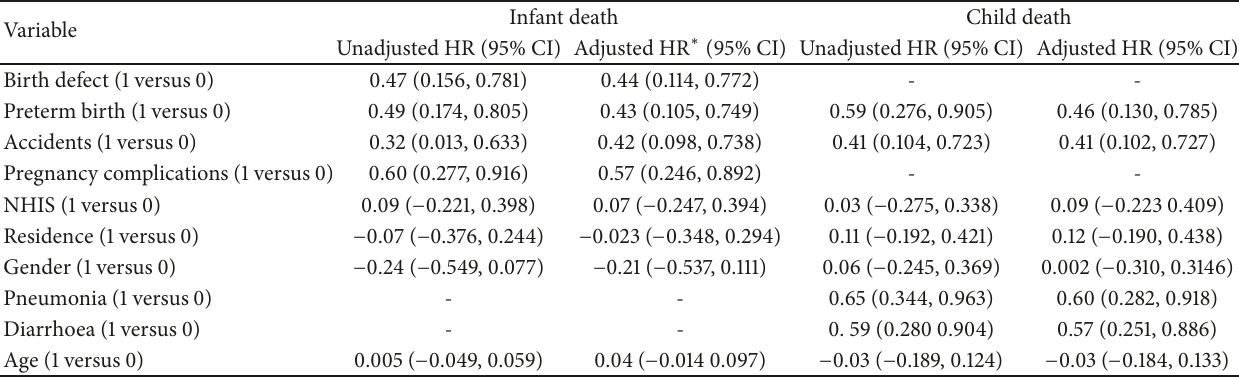
Table 2: Parameter estimates from the Cox proportional hazard regression model for infants and children (n =